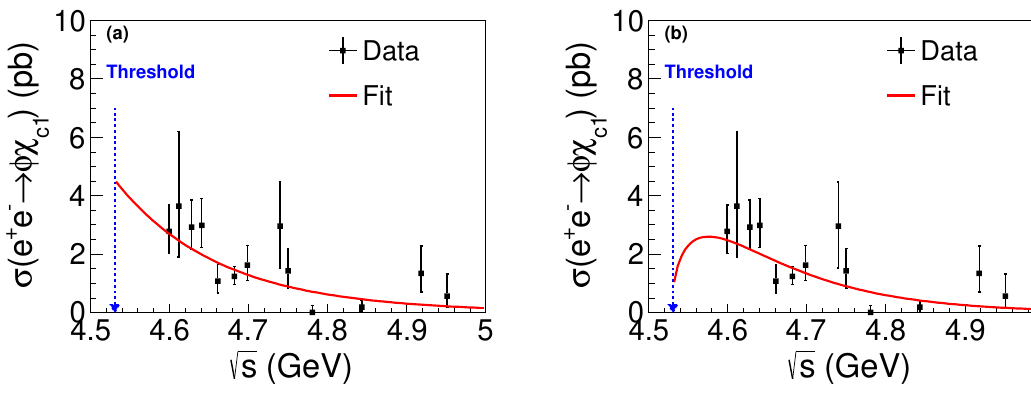
Figure 5 . Fit to the cross section of e + e − → φχ c 1 with (a) the continuum amplitude and (b) the PHSP corrected continuum